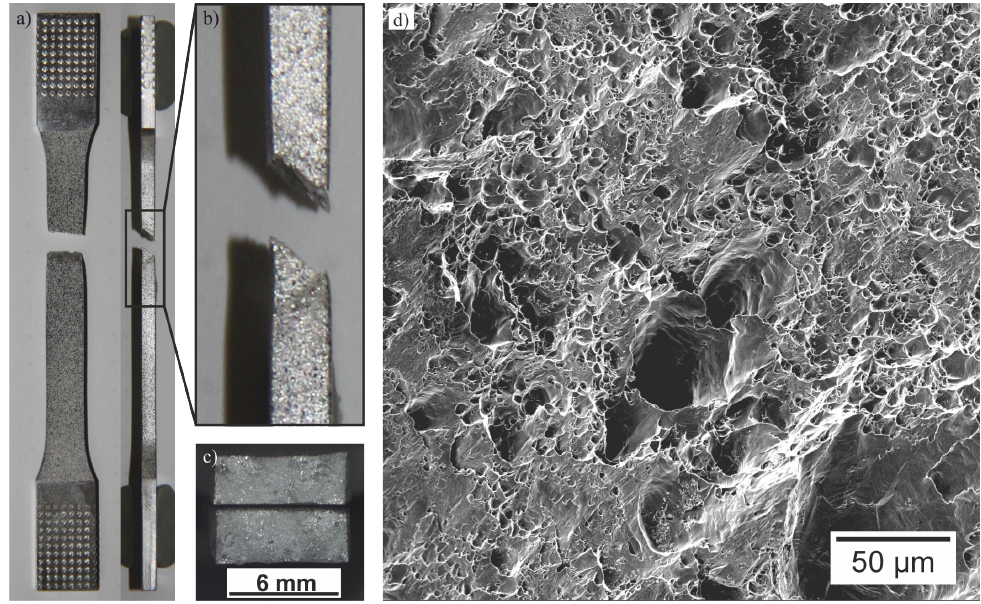
Figure 10. Fracture mode of tensile specimens: ( a ) front- and side view, ( b ) fracture zone (side view), ( c ) fracture surfaces and ( d ) fracture surface with 1000 ×